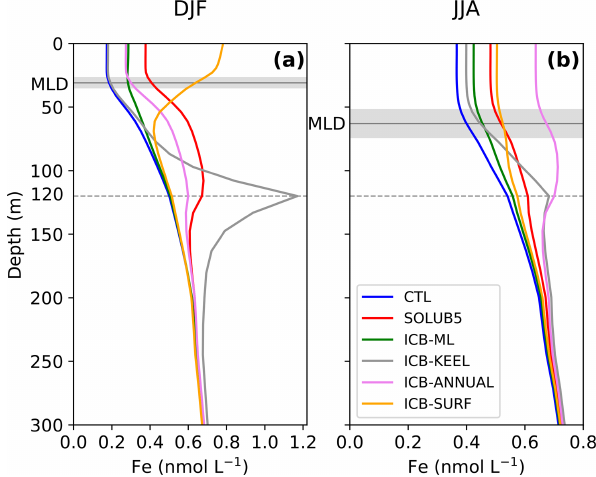
Figure 6. Vertical profiles of Fe concentrations until 300m north- east of the Antarctic Peninsula (36–56 ◦ W, 58–63 ◦ S) in the CTL (blue), SOLUB5 (red), ICB-ML (green), ICB-KEEL (gray), ICB- ANNUAL (pink), and ICB-SURF (orange) experiments in (a) sum- mer (December, January, and February) and in (b) winter (June, July, and August). The solid light gray line is the mixed layer depth (MLD) in (a) summer and (b) winter averaged over the region, in gray shading is the standard deviation of the MLD over the region in (a) summer and (b) winter, and the dashed gray line is the 120m